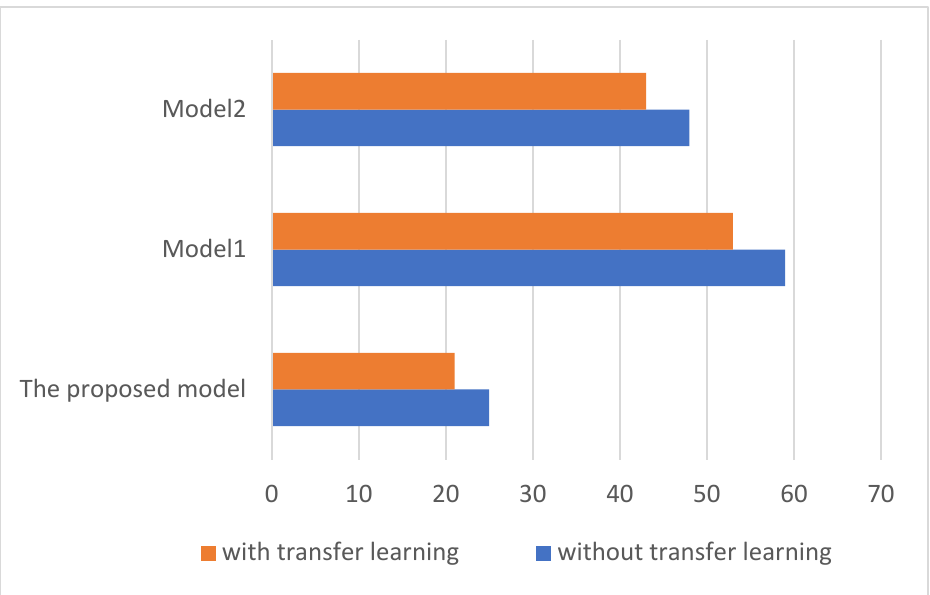
Figure 6. Prediction time of the model with and without transfer learning versus other models.